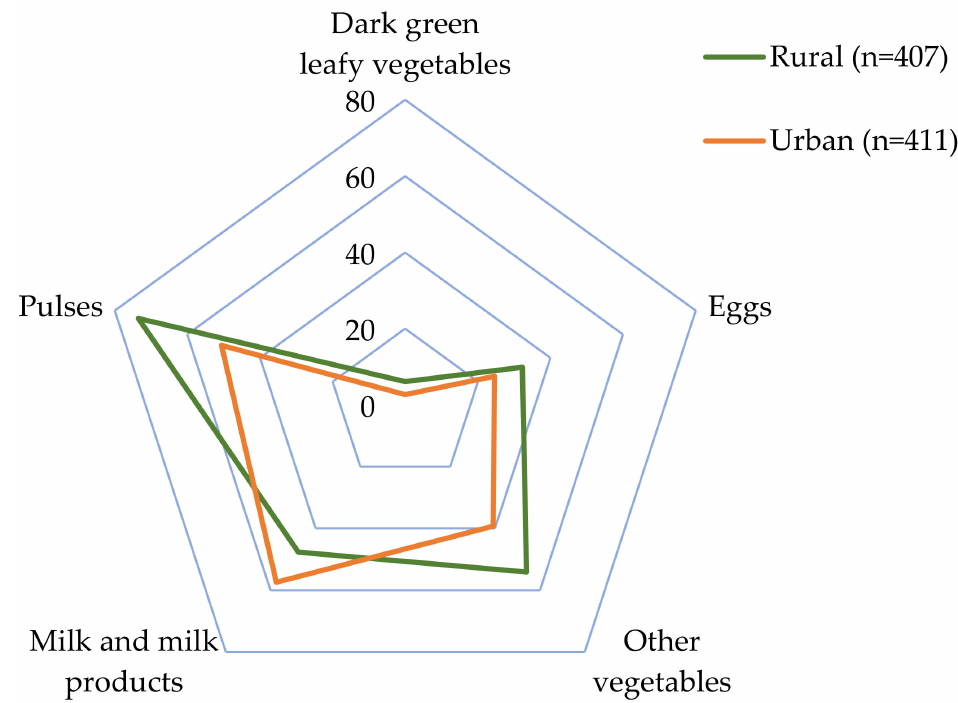
Figure 2. Proportion of participants consuming at least 15 g of each food group over one-day food record, according to residence